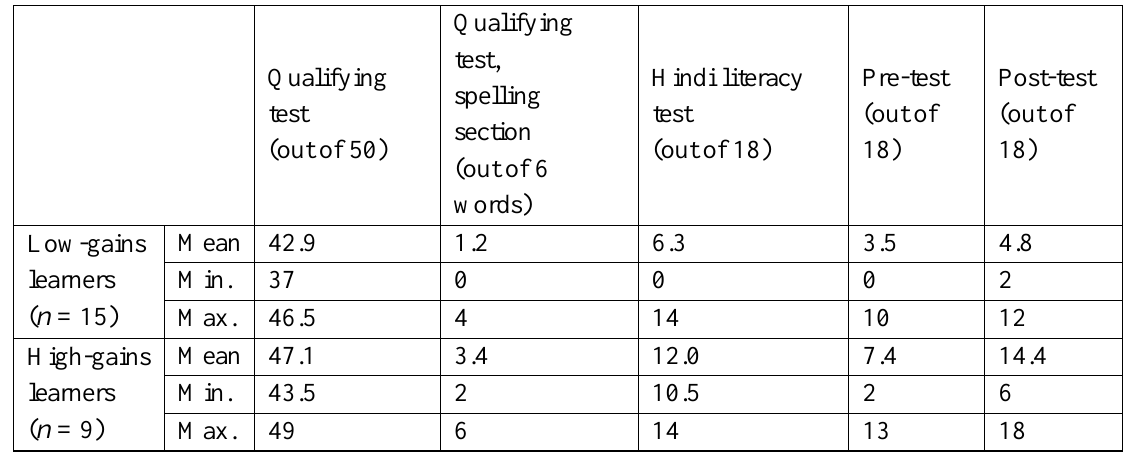
High-Gains vs. Low-Gains Learners in Terms of Test Scores (Adapted from Kam et al., 2009)